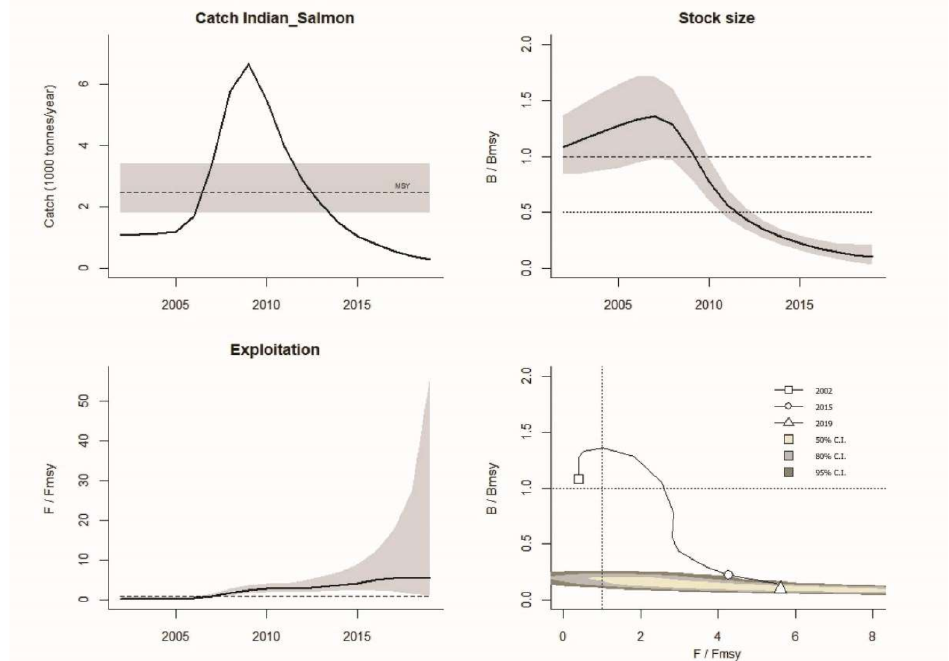
Figure 3. Graphical findings of BSM method for the L. indicum fishery in the BoB, Bangladesh coast.